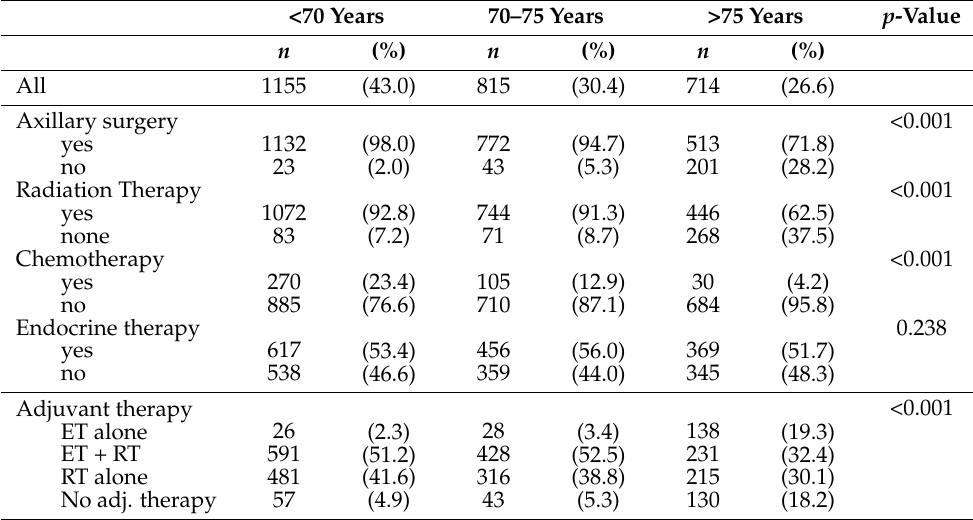
Table 2. Treatment characteristics divided per age group for patients with invasive tumors ( n = 2684). All patients underwent breast-conserving